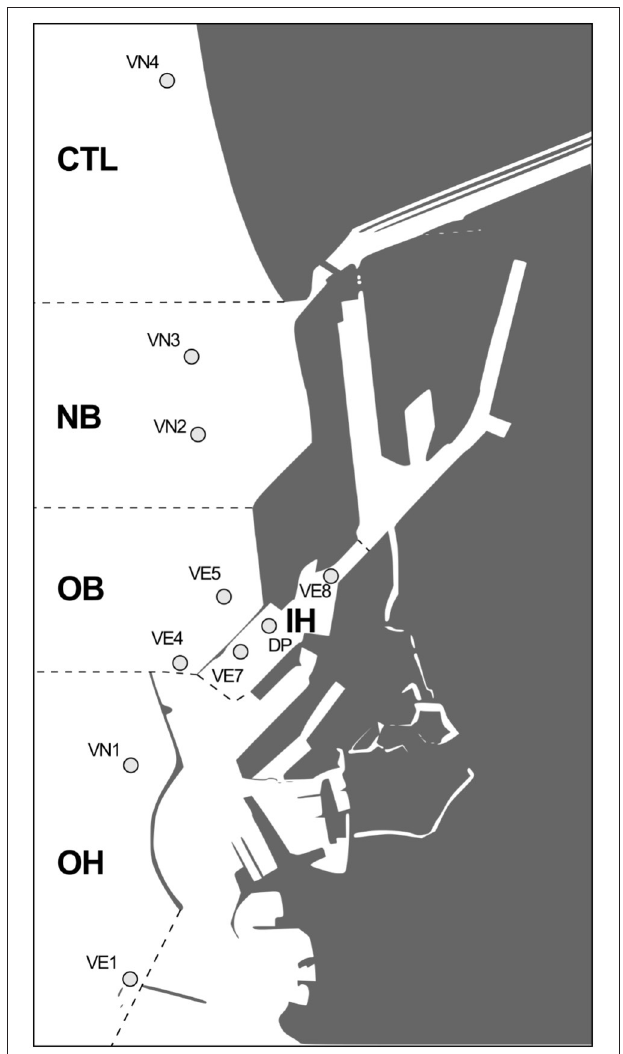
FIGURE 1 | Study area, with detail of each investigated section within the area and sites within. CTL, control area, VN4 site; NB, new CDF area, VN2 and VN3 sites; OB, old CDF area, VE4 and VE5 sites; IH, inner harbor area, source of dredged materials, VE7, VE8 and DP sites; OH, outer harbor area, VN1 and VE1